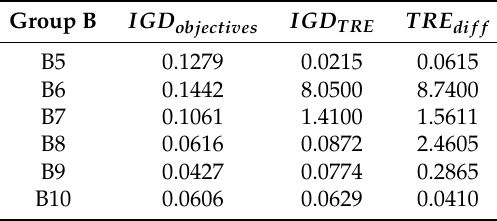
Table 3. IGD values for prone-supine Group B.